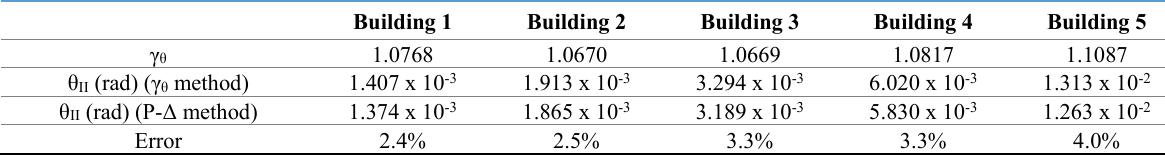
Table 3. γ θ coefficient calculation and comparison with P- Δ method ( second analysis).